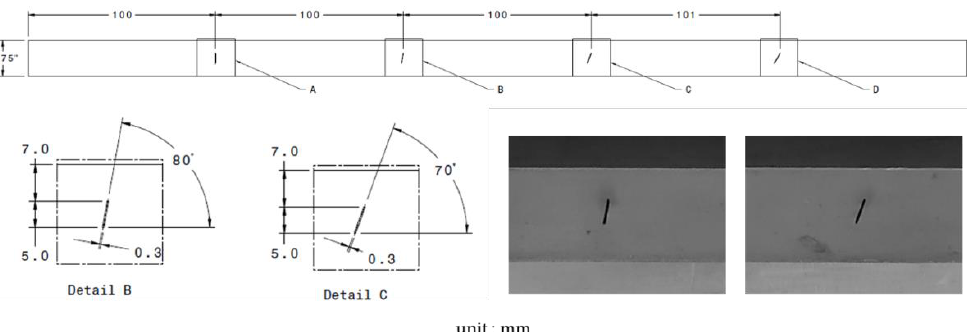
Figure 9. The ¾ ″ thick low-carbon steel sample plate. Four angled notches of 0.3 mm width were grooved using electrical discharge machining (EDM). Details (left) and pictures (right) are for a 70° (notch C) and 80° (notch B).